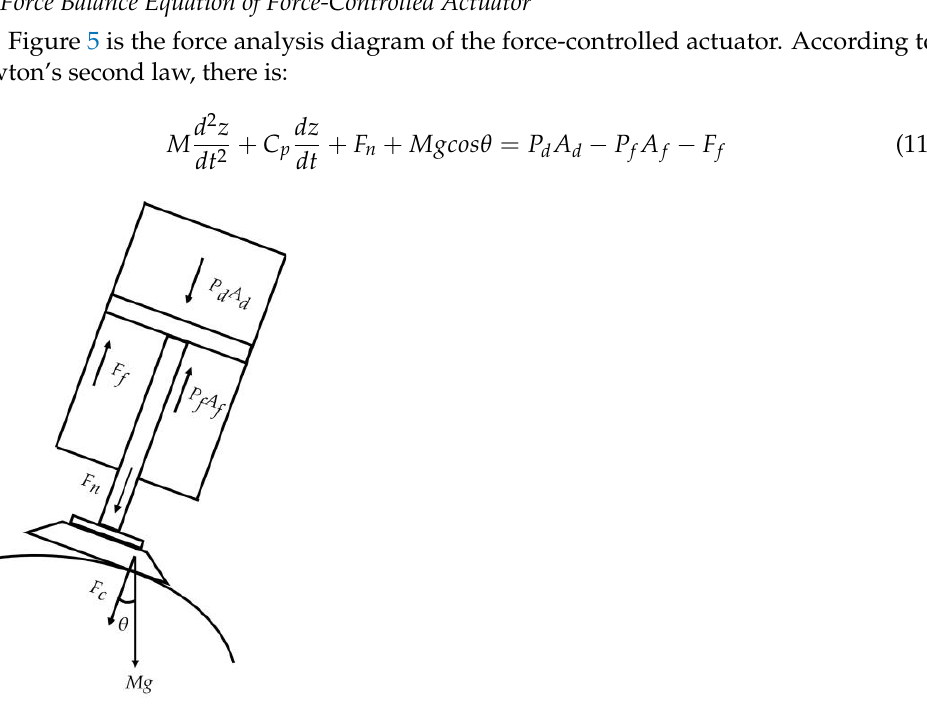
Figure 5. Force analysis of force-controlled actuator.